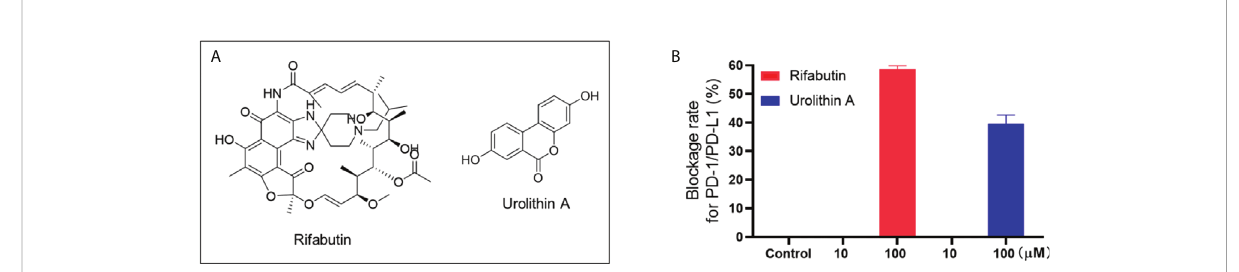
FIGURE 3 Chemical structure of rifabutin and UA (A) . Blockade rate of rifabutin and UA (at 10 and 100 m M) on the PD-1/PD-L1 interaction determined by the pair ELISA assay (B)